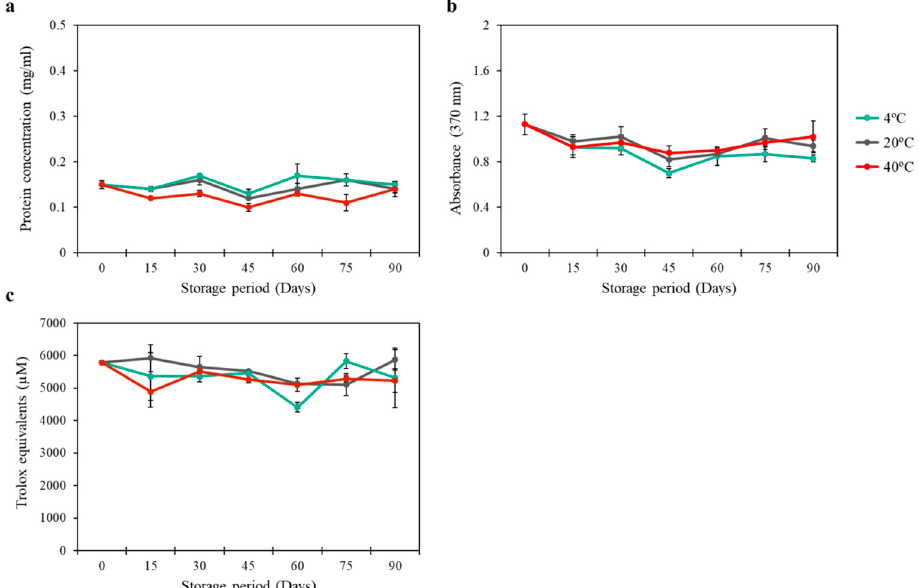
Figure 2. Protein (mg/mL) stability ( a ), color (absorbance at 370 nm) stability ( b ), and antioxidant activity ( µ M Trolox Equivalents (TE)) ( c ). Measurements were carried out over 90 days, at 4 ◦ C (blue), 20 ◦ C (grey), and 40 ◦ C (red), for cauliflower inflorescence vesicles (CI-vesicles) with encapsulated PG-E. Data are means ± SE ( n = 3).